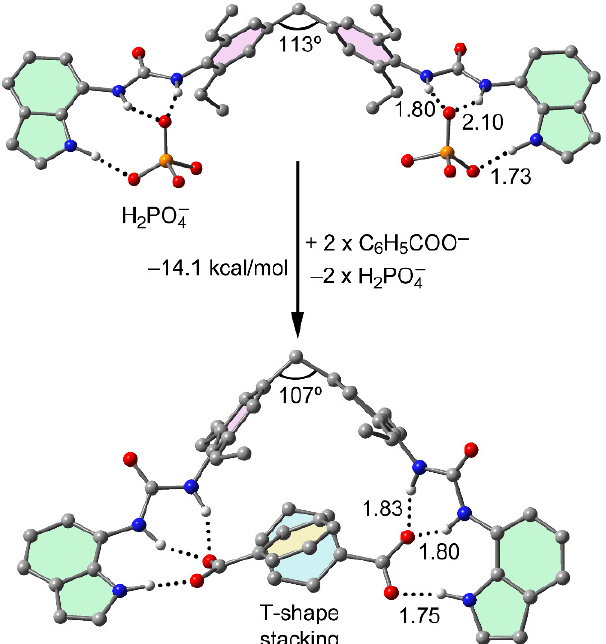
Figure 4. Optimised geometries (PB86-D3/def2-TZVP in DMSO) of the host-guest complexes of L1 with BzO − ( bottom ) and H 2 PO 4 − ( top ) anionic guests. Distances in Å. H atoms were omitted for clarity apart from those belonging to the NHs.